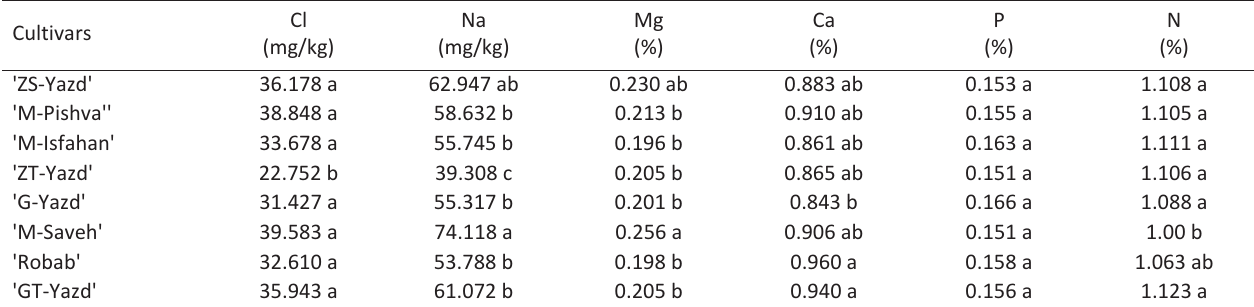
Table 5 ­ The comparison of root mineral elements in eight pomegranate cultivars Cultivars